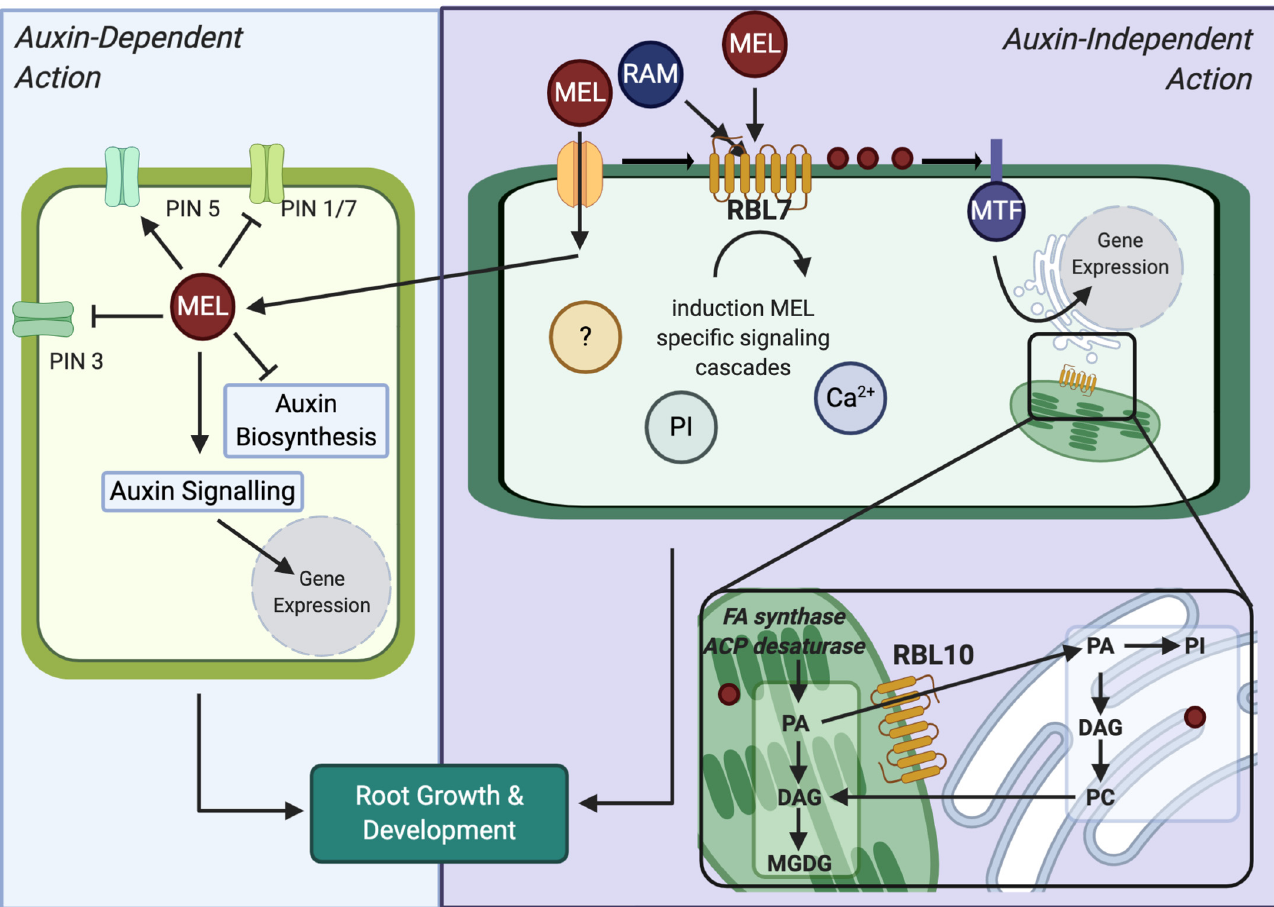
Figure 7. Proposed hypotheses for melatonin mediated root growth through auxin-dependent and independent actions. ACP, acyl carrier protein; FA, fatty acid; MEL, melatonin; MTF, membrane- bound transcription factor; PA, phosphatidic acid; PC, phosphatidylcholine; DAG, diacylglycerol; MGDG, monogalactosyldiacylglycerol; PI, phosphatidylinositol; RAM, ramelteon; RBL, rhomboid- like protein.